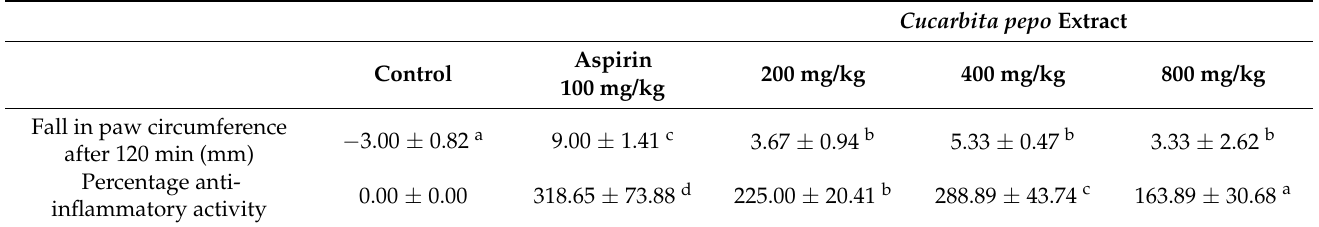
Table 9. Change in paw circumference and percentage anti-inflammatory activities after 120